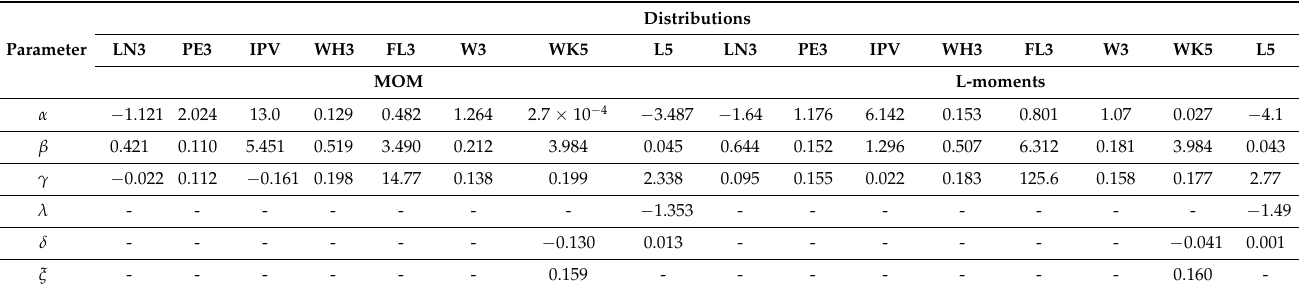
Table 9. The estimated values of the parameters.